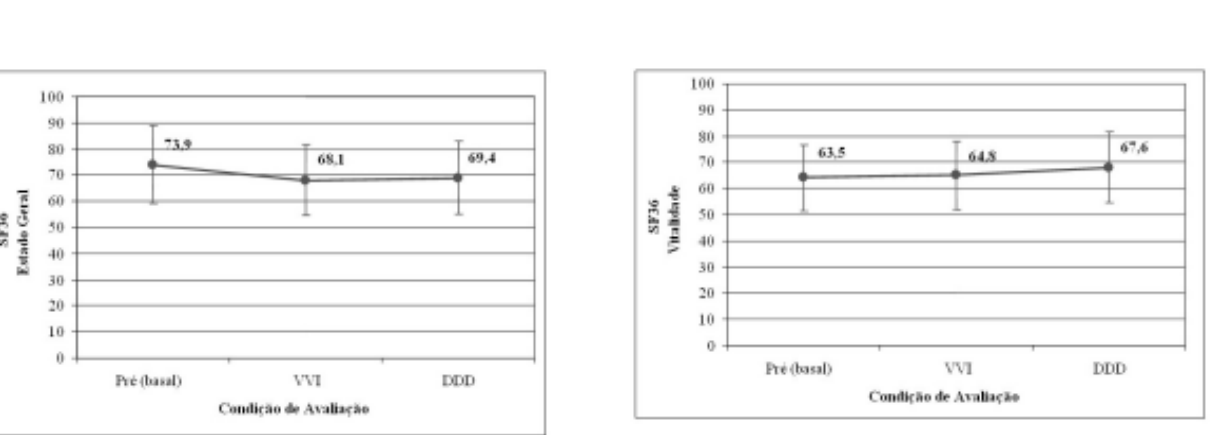
Fig. 3 - Qualidade de vida avaliada pelo estado geral (p=0,546), nas condições Pré (basal), VVI e DDD, dos pacientes com cardiopatia chagásica e bloqueio atrioventricular. Total de pontos (SF36) da avaliação do estado geral representados em média e desvio-padrão; DDD: condição do paciente após 90 dias de estimulação atrioventricular; p: nível descritivo do teste de variância para medidas repetidas; Pré (basal) condição do paciente em estimulação ventricular exclusiva na seleção do estudo; VVI: condição do paciente após 90 dias de estimulação ventricular